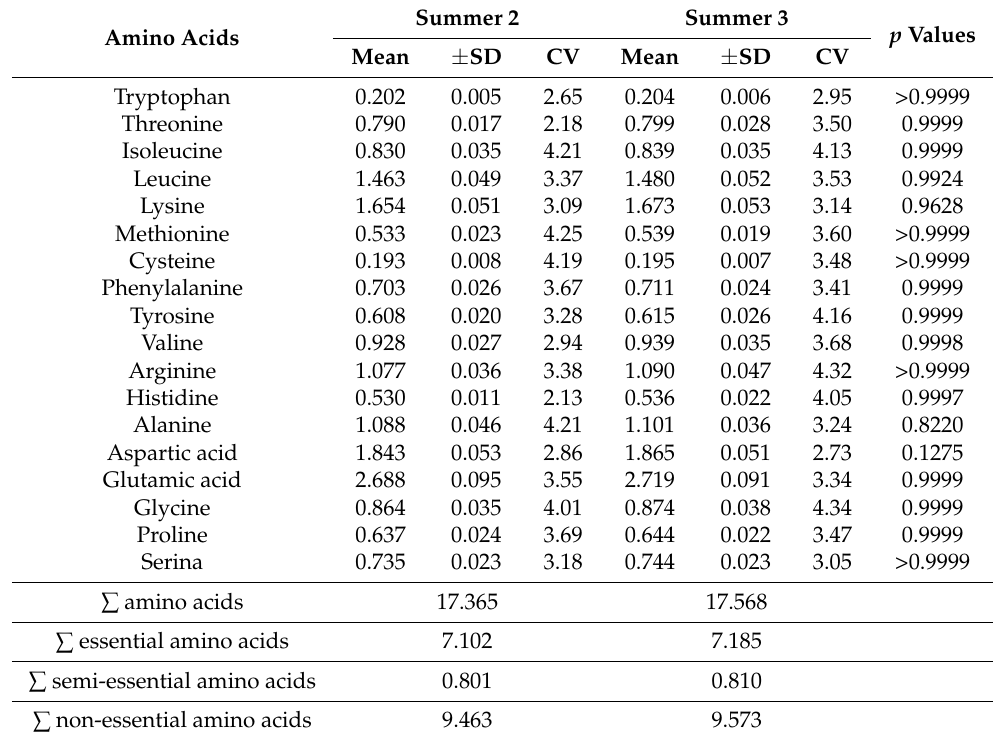
Table 8. Amino acids content (g/100 g) in the fillets sampled from Polyodon spathula sturgeons aged two and three